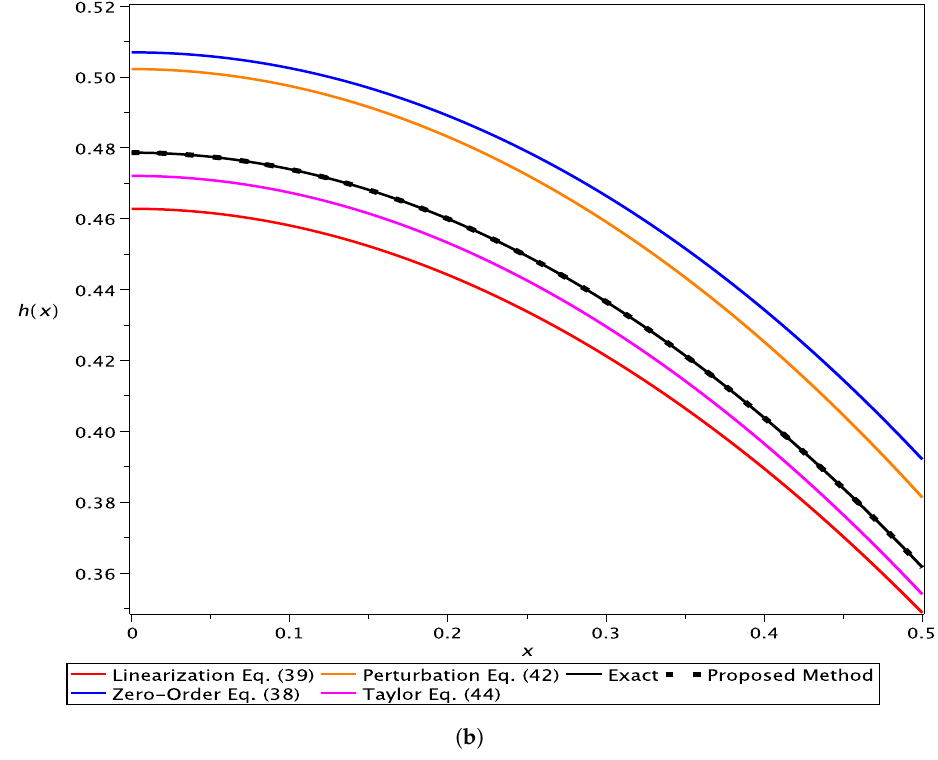
Figure 2. Comparison of approximate solutions obtained by the proposed method ( h 5 ( x ) ) and other methods for Equation (2) with a = 1 and b = 1. ( a ) Entire domain ( 0 ≤ x ≤ 1 ) . ( b ) Closeup ( 0 ≤ x ≤ 0.5 )